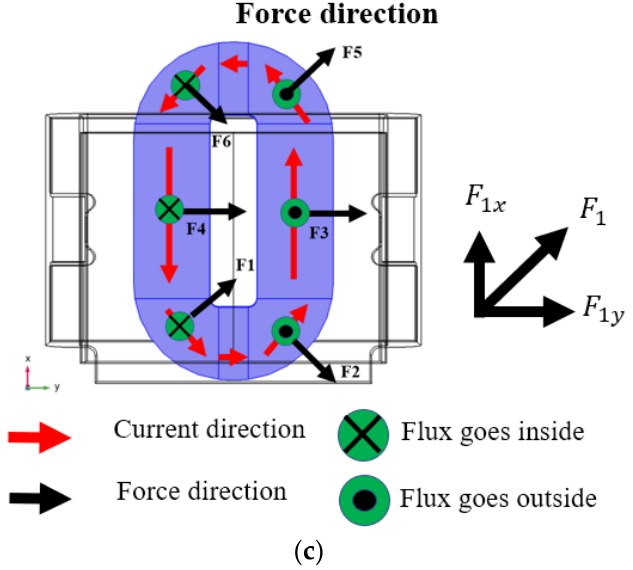
Figure 3. Force calculation of the HLVM: ( a ) magnetic circuit and magnetic flux direction; ( b ) parts of coil; ( c ) force direction on different parts of coil.